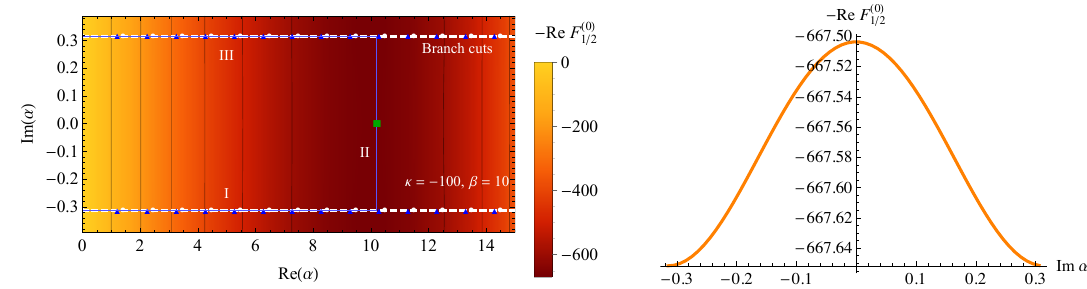
Figure 8 . Left : we show the value of (cid:0) Re( (cid:12)F (0) q ) for complex values of (cid:11) for (cid:12) = 10 and (cid:20) = (cid:0) 100. The branch cuts are indicated by white dashed lines and start at the white dots where there are logarithmic divergences. The blue triangles indicate the saddle-points where (cid:11) takes a non-zero imaginary value while the green square indicates the real saddle-point. The blue lines show the three-piece contour ( I , II , and III ) for which the real saddle-point dominates in the path integral. Right : we plot the value of (cid:0) Re( (cid:12)F (0) q ) along contour II which shows that the real-saddle point indeed dominates in the path